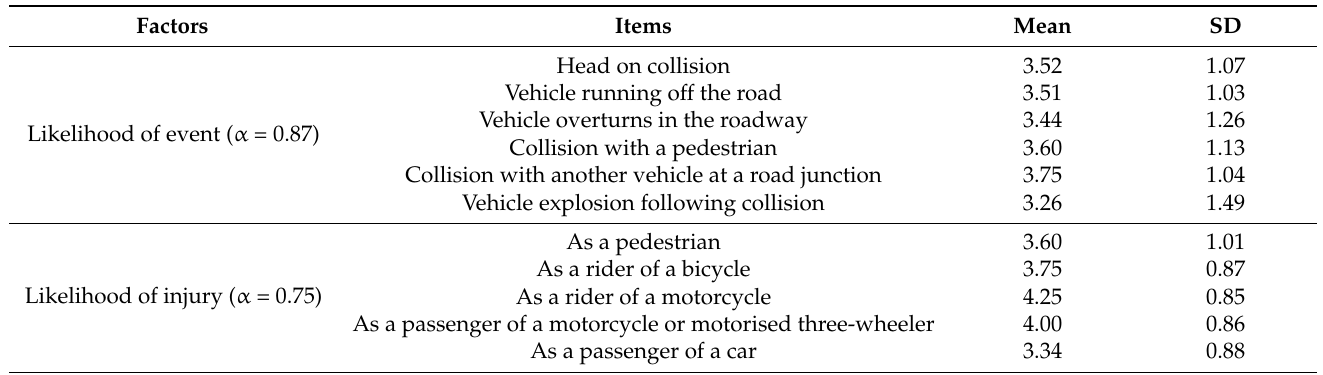
Table 3. The alpha values, means and standard deviations for on road risk